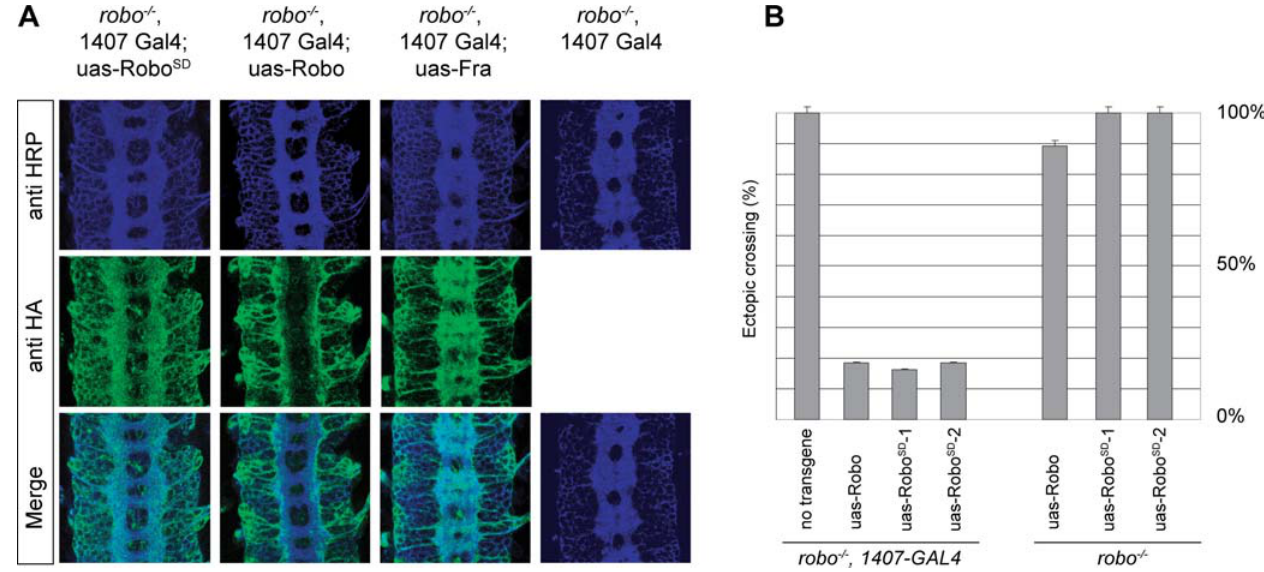
Figure 6. Rescue of a robo mutant with Robo SD transgenes. (A) Expression of Robo or Robo SD transgenes in a robo 1 mutant embryo using the UAS-GAL4 system completely rescues the commissural phenotype while expression of Frazzled does not. (B) Quantification of above. Embryos of the indicated genotype were stained with ID4 (anti-Fas2) antibody labeling the longitudinal fascicles and dissected to score the percentage of ectopically crossing fascicles. Two independent insertions of a Robo SD transgene were used and all showed levels of rescue comparable to the uas-robo control.